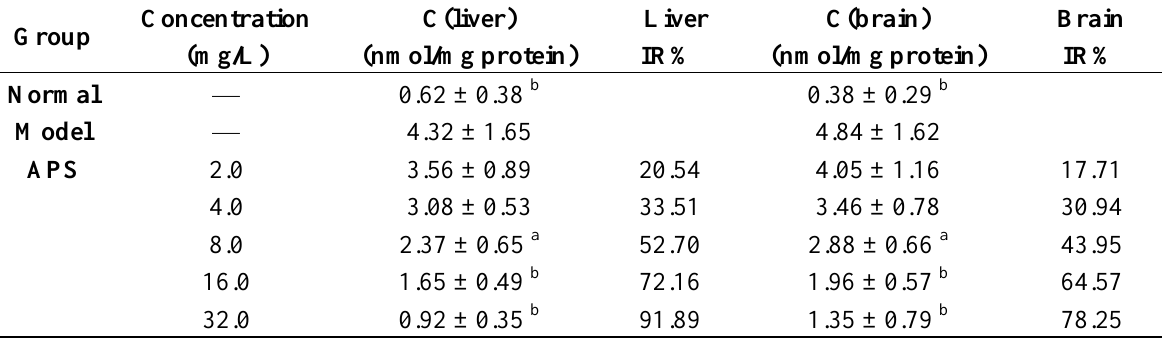
Table 1. The effects of Astragalus polysaccharides (APS) on thiobarbituric acid reactive substances (TBARS) in liver and brain mitochondria (n = 6). Data were expressed as means ± S.D. and statistical differences between groups were analyzed by one-way analysis of variance